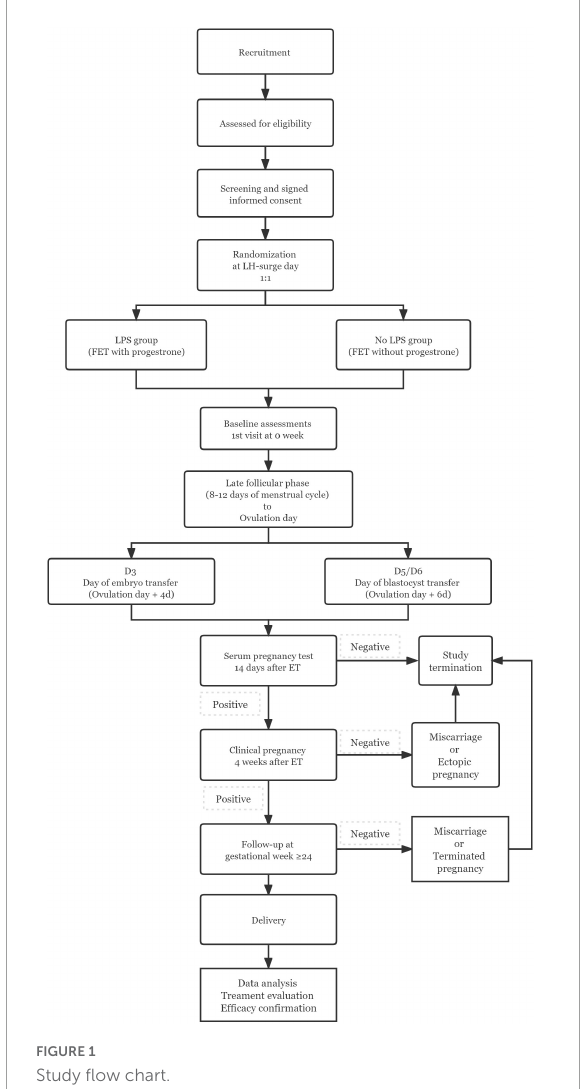
FIGURE1 Study flow